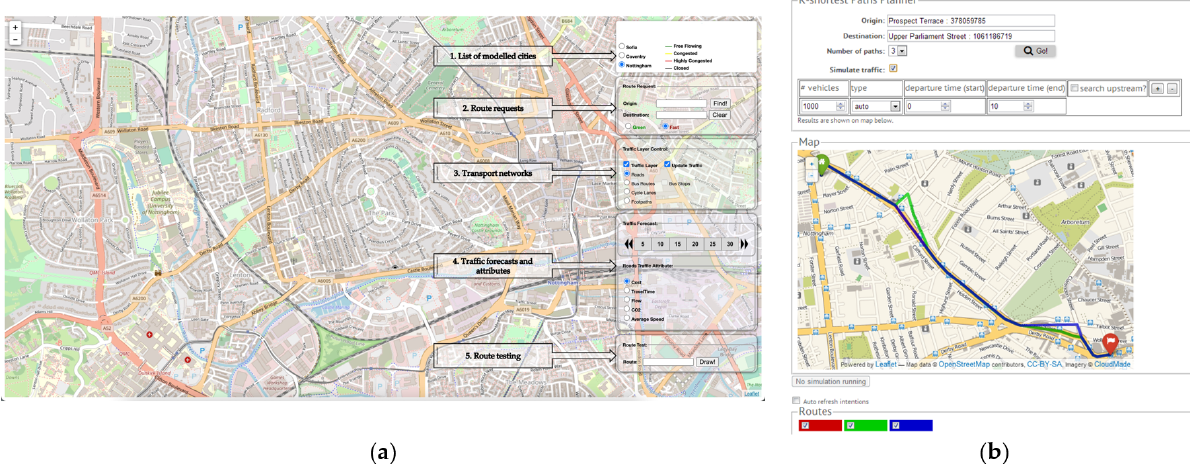
Figure 10. ( a ) A visualization web client for the traffic management center operators, with Open Street Map (OSM) set to Nottingham (United Kingdom). ( b ) K-shortest path planner tool.